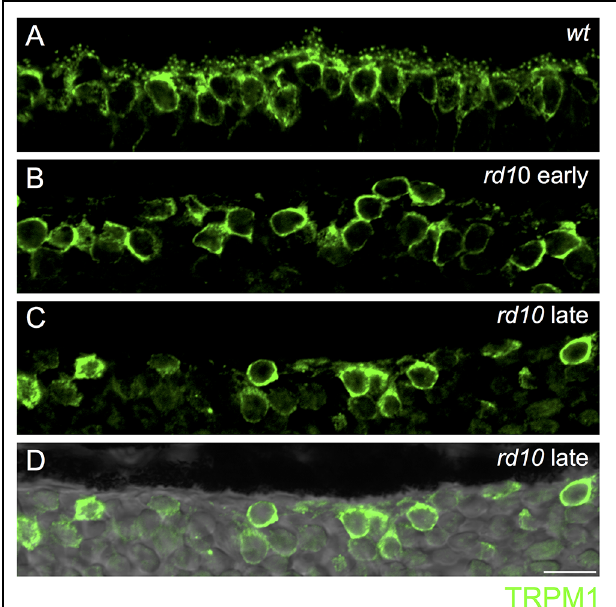
FIGURE 4 | Loss of synaptic TRPM1 expression in rd10 retina. (A) Region of outer wild-type retina showing TRPM1 immunoreactivity. Note the strong punctate labeling in the dendritic tips of the bipolar cells. Strong somatic labeling is also evident. (B–D) Loss of synaptic TRPM1 expression in the early (B) and late (C) rd10 retina. Punctate staining is absent in the rd10 retina indicating a lack of synaptic expression. However, strong labeling remains in On bipolar cell somata. (D) Same area as in (C) overlayed on the transmitted light image to show the lack of retinal photoreceptors in this region. Scale bar = 10 μ